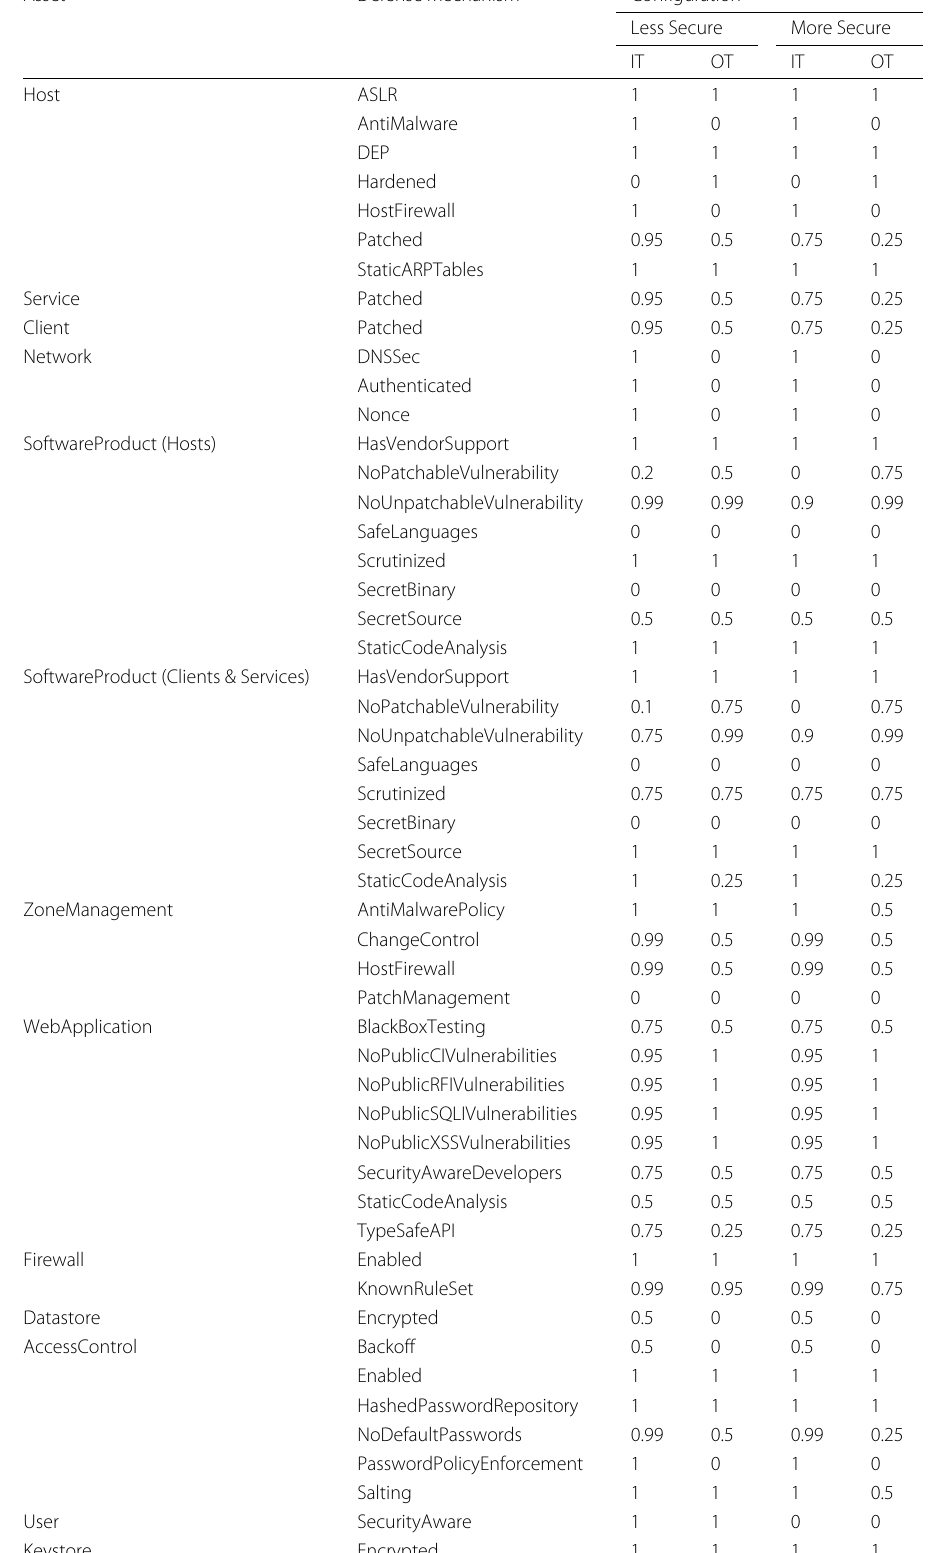
Table 7 Defense mechanism configurations defined in securiCAD for cyber security Analysis Asset